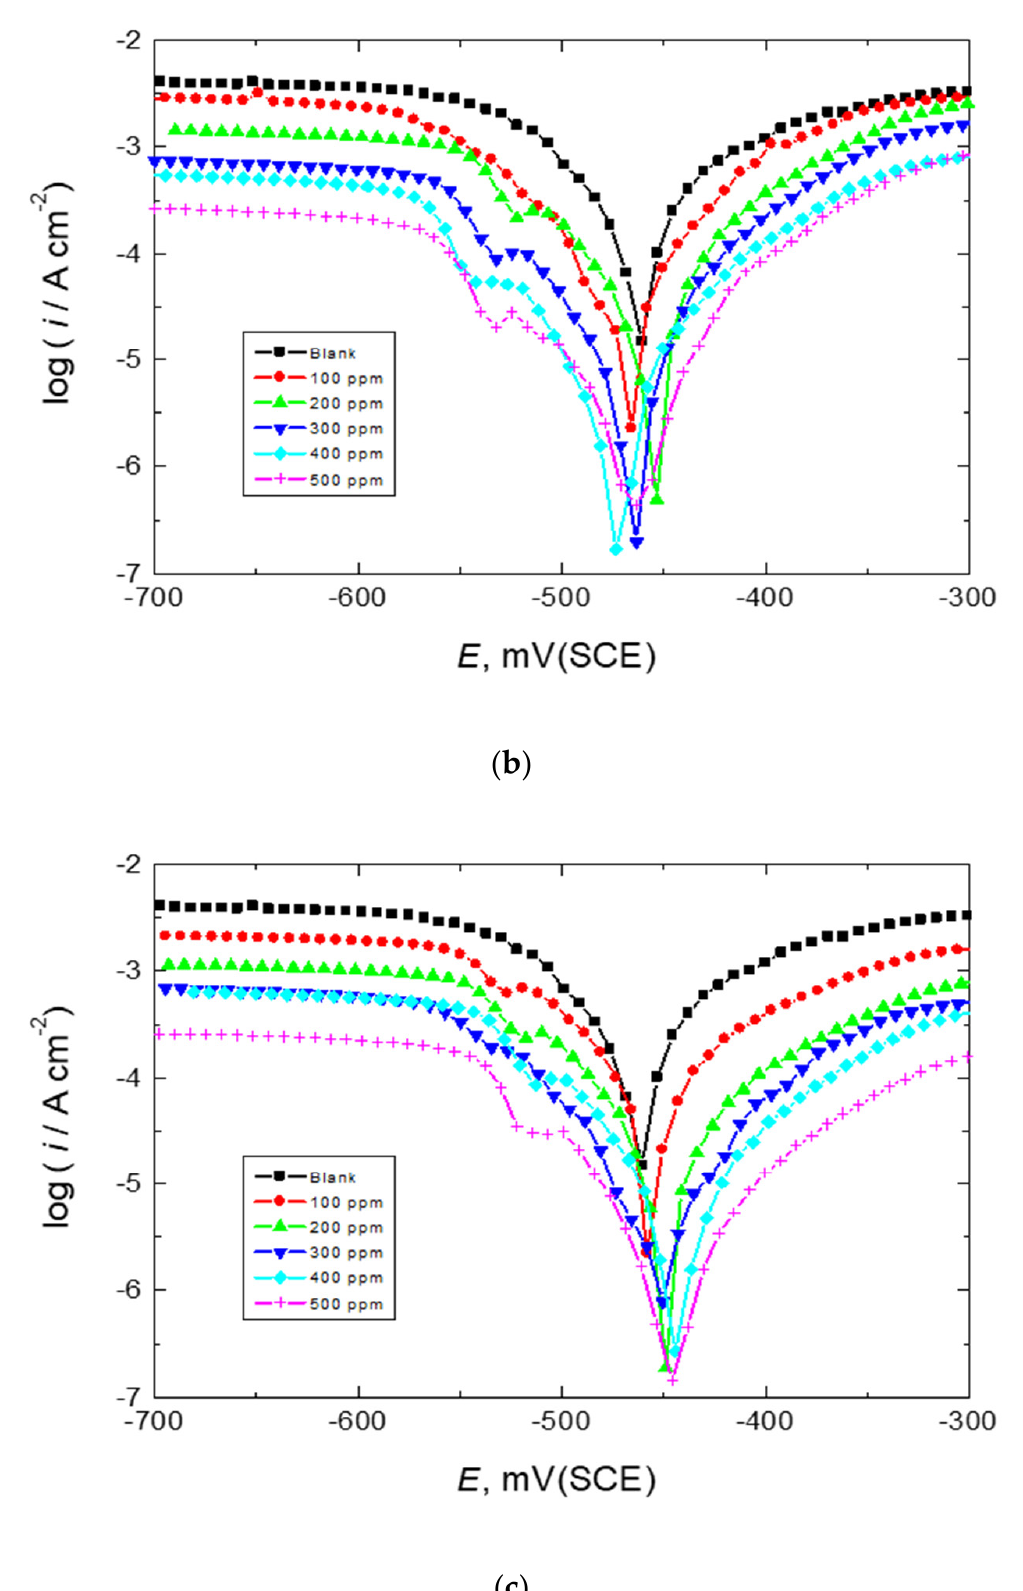
Figure 3. PDP curves (Tafel plots) for mild-steel corrosion in 0.5 M HCl solution at 303 K in absence and presence of the examined carbohydrate polymers: ( a ) Chi, ( b ) Pec, and ( c ) A-Pec. Table 1. Corrosion parameters for mild-steel corrosion in 0.5 M HCl solution in absence and pres- ence of the examined carbohydrate polymers at 303 K.